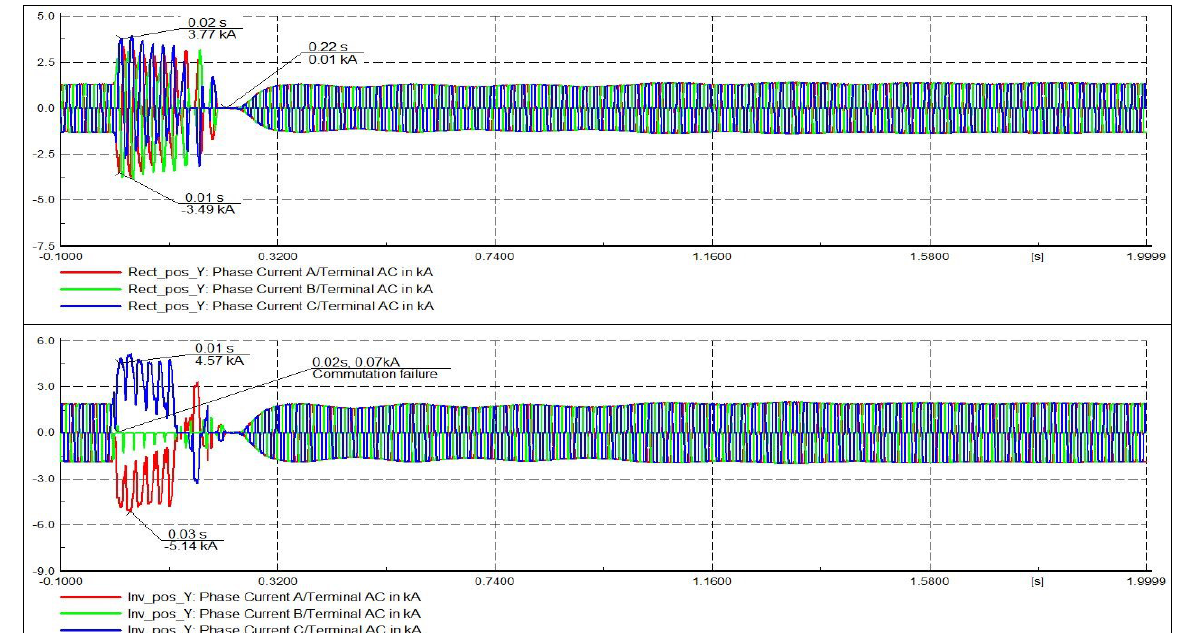
Fig. 9. LCC HVDC converter current during